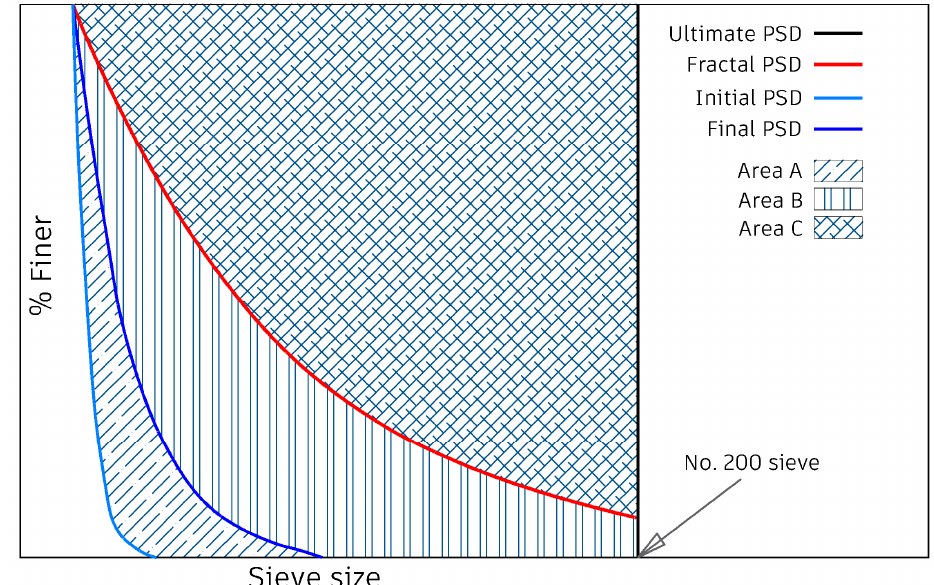
r bal and B bal